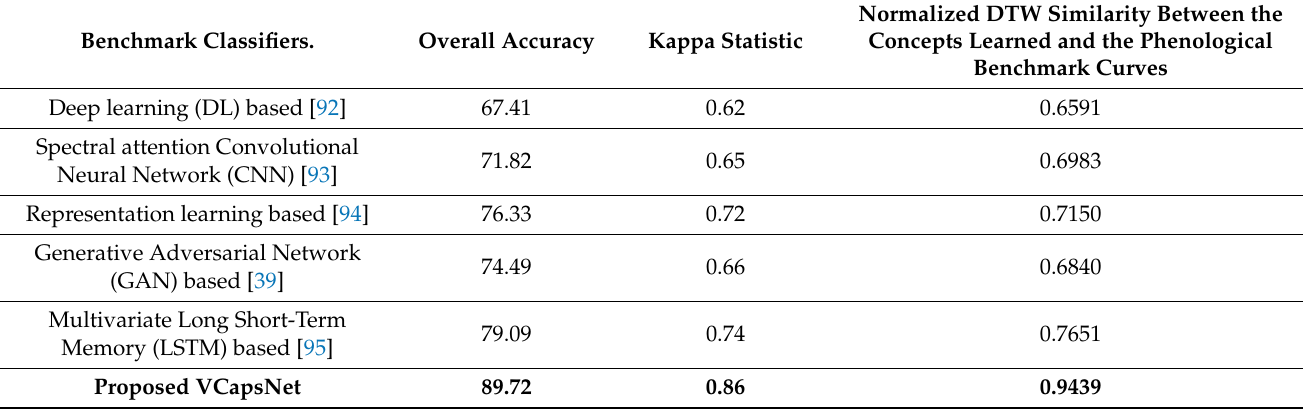
Benchmark Classifiers.